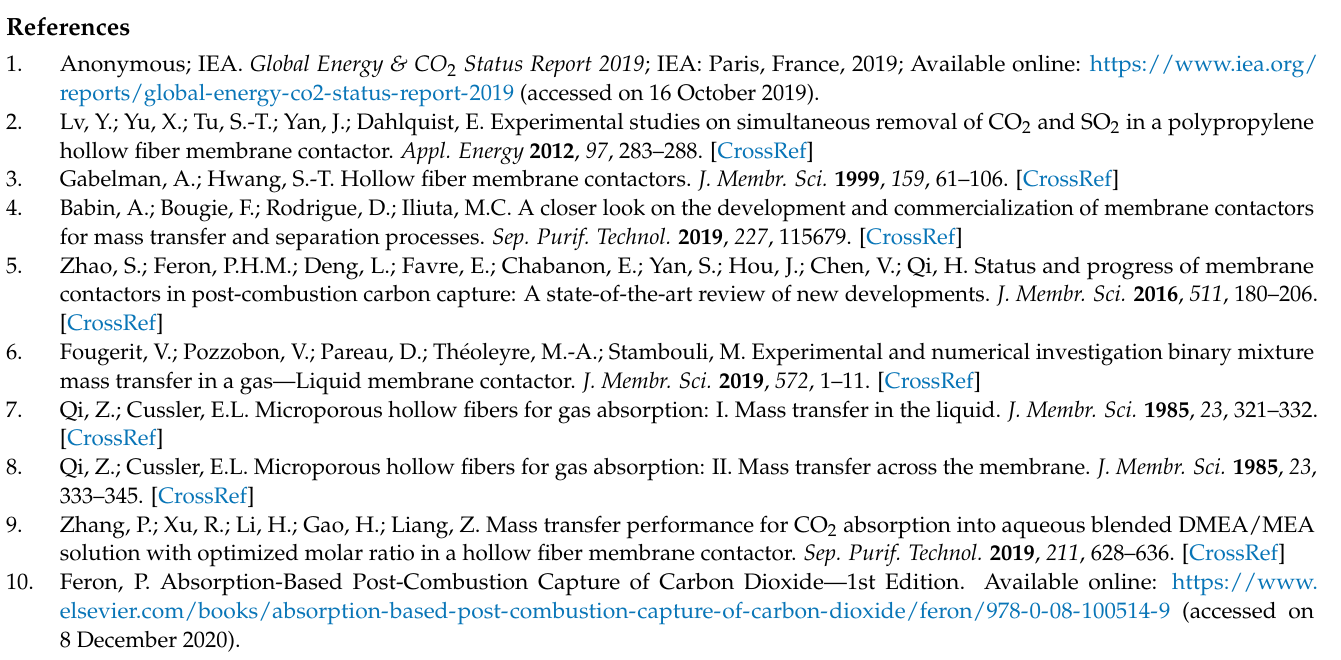
Figure A1. Results of repetition in terms of N 2 purity and recovery rate ( Q l = 150 L h − 1 , P g = 3 bar g , Q g = 100 NL h − 1 , y CO 2 (cid:3036)(cid:3041) = 35%).